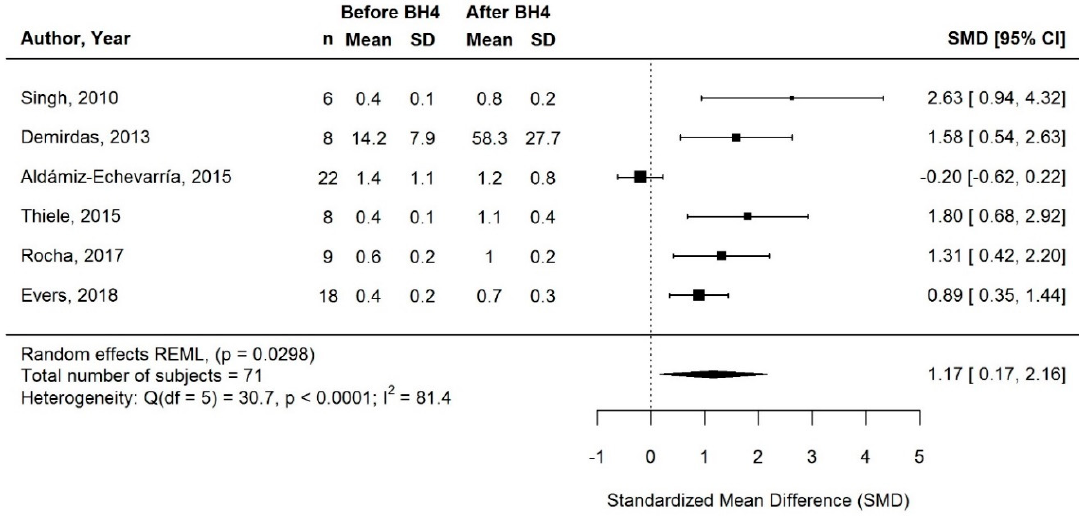
Figure 2. Standardized change in phenylalanine intake of long-term responders on BH4 treatment. Means and SDs before/after BH4 are milligram phenylalanine per kilogram bodyweight per day for Belanger-Quintana (2005), Singh (2010), and Aldámiz-Echevarría (2015), and milligram per day for all other studies. Abbreviations: BH4, tetrahydrobiopterin; CI: confidence interval; n: sample size; SD: standard deviation; SMD, standardized mean difference.